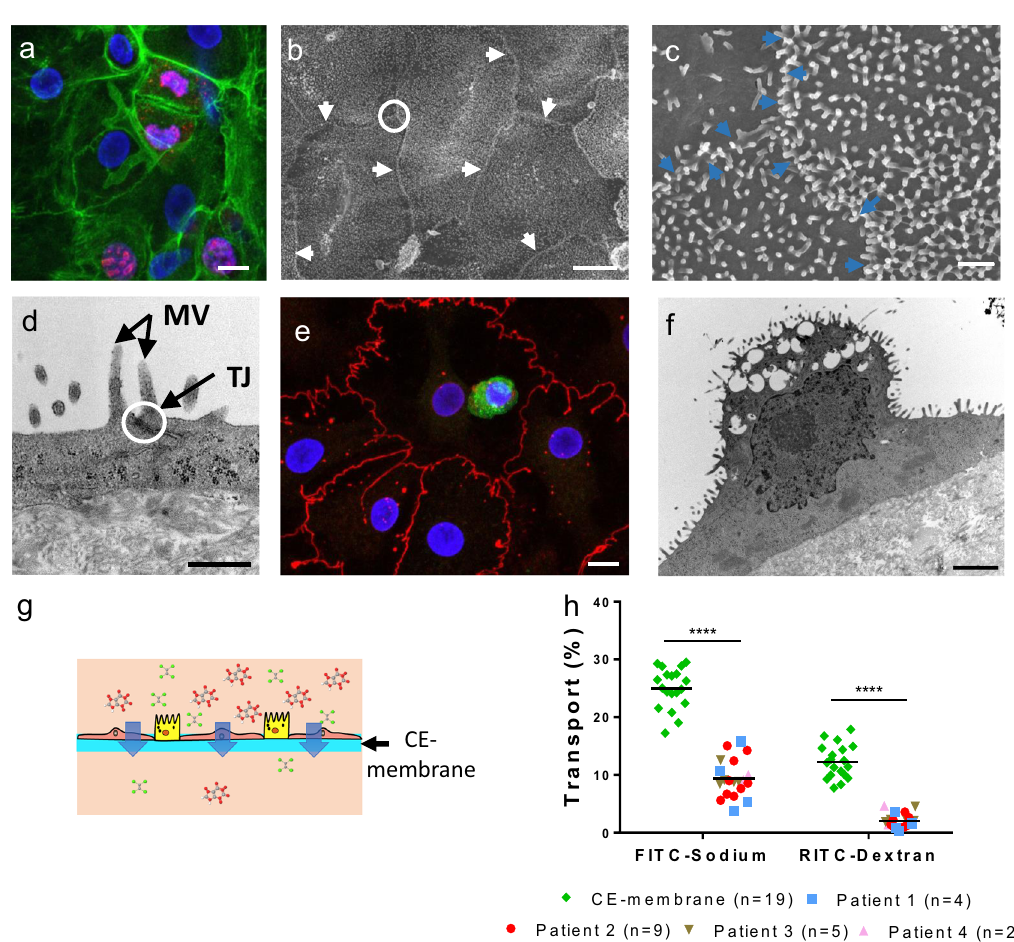
Fig. 5 Primary lung alveolar epithelial cells. a Expression of Ki-67 marker on hAEpC at day 4. Actin (green), Ki-67 (red) and Hoechst (blue). Scale bar: 10 µ m. b SEM picture of hAEpC at day 14, illustrating tight cell – cell contacts. White arrows: cells border; white circle: area zoomed in c . Scale bar: 10 µ m. c Intersection between three cells at day 14, showing their interface and a multitude of microvilli. Blue arrows: cells border. Scale bar: 1 µ m. d TEM picture of tight junction (TJ) between two hAEpC. Apical microvillis (MV) typical to type II alveolar epithelial cells can clearly be seen. Scale bar: 500 nm. e Expression of surfactant protein-C (SP-C, green), tight junction (Z0-1, red) and nuclei (Hoechst, blue) at day 4. Scale bar: 10 µ m. f TEM picture of a hAEpC type II-like cell at day 4, showing its microvilli and empty spaces, where lamellar bodies were located. Scale bar: 2 µ m. g Schematic of the transport of molecules across the CE membrane cultured with alveolar epithelial cells. h Transport of FITC – sodium and RITC – dextran molecules across the CE membrane ( n = 19) after 4 h of incubation with hAEpC the experiments were carried with cells from four patients ( n =